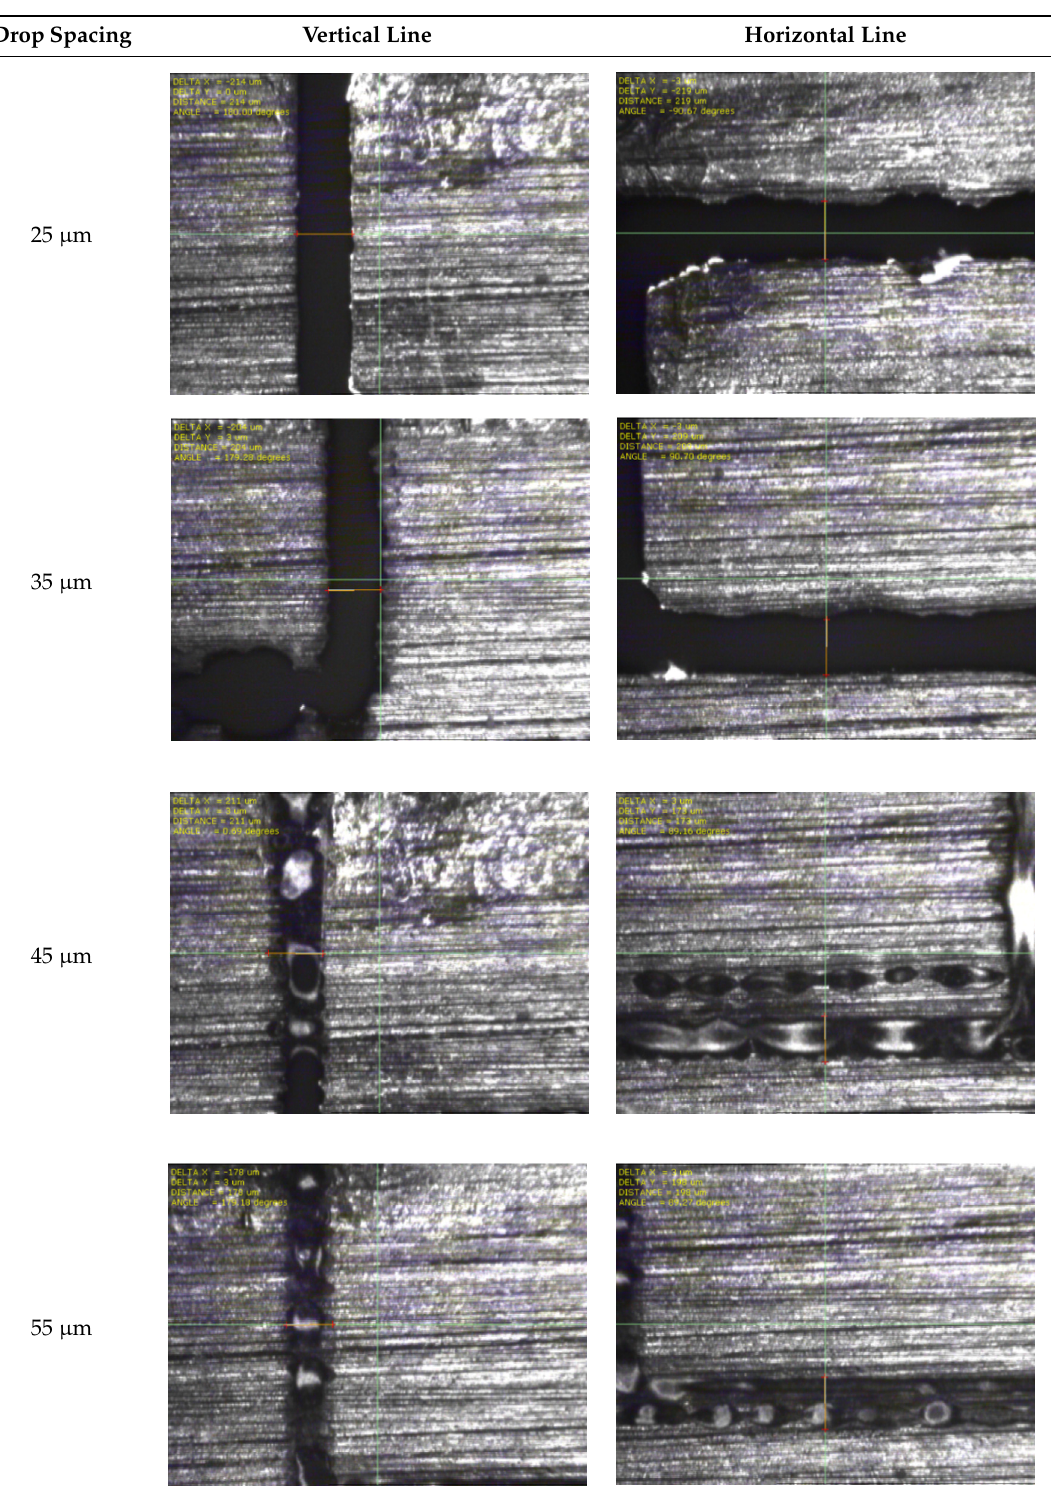
Figure 6. Comparison graph of vertical and horizontal line tolerance varying to the drop spacing. Figure 7 shows the fabricated prototype and a magnified view of the printed surface. The prototype had dimensions of 198 mm × 198 mm and 67 × 67 unit cells. The horizontal and vertical widths of the printed surface were 0.196 and 0.193 mm, respectively, as shown in Figure 7, and they were very close to the value of 0.2 mm used in the simulation. Figure 8 shows a schematic and a photograph of the measurement setup. For performing measurements of the prototype, the distance was set between the prototype sample and a horn